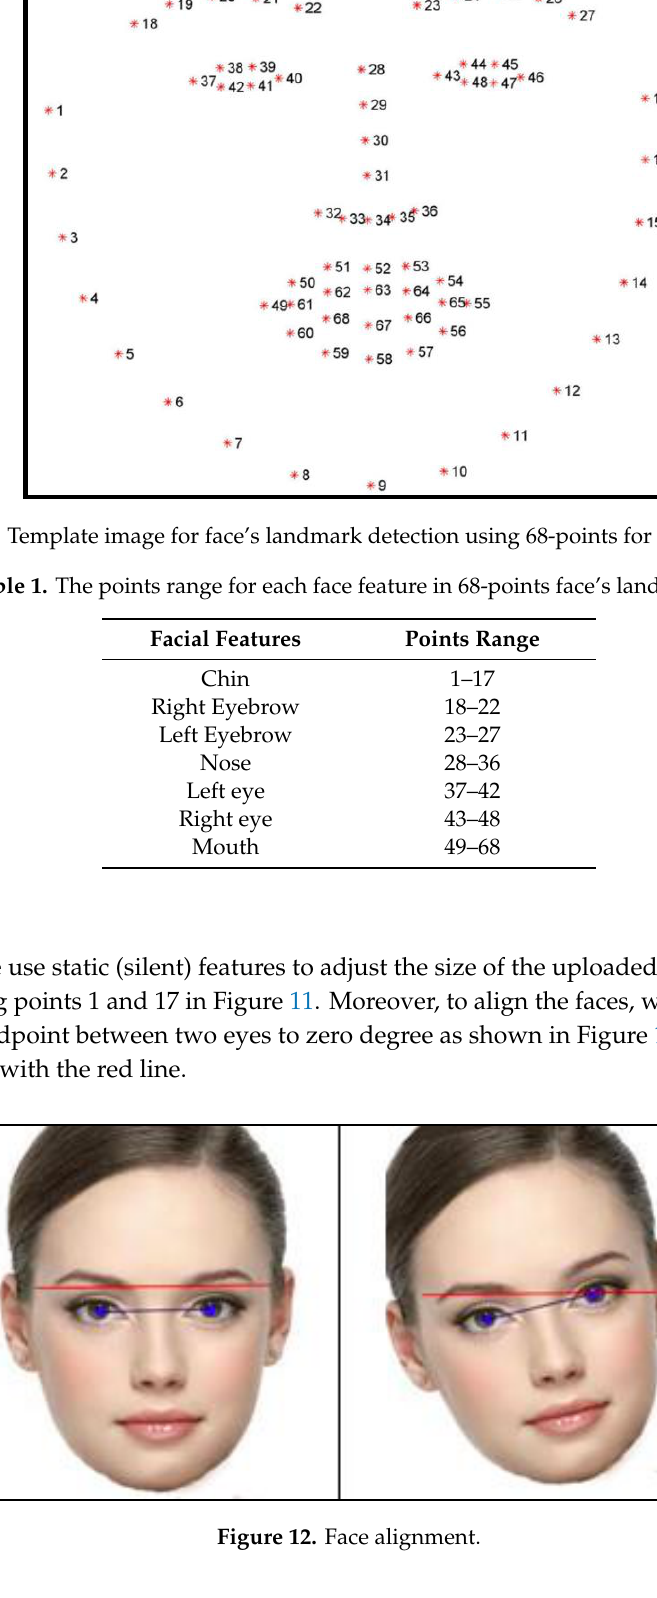
Figure 12. Face alignment.